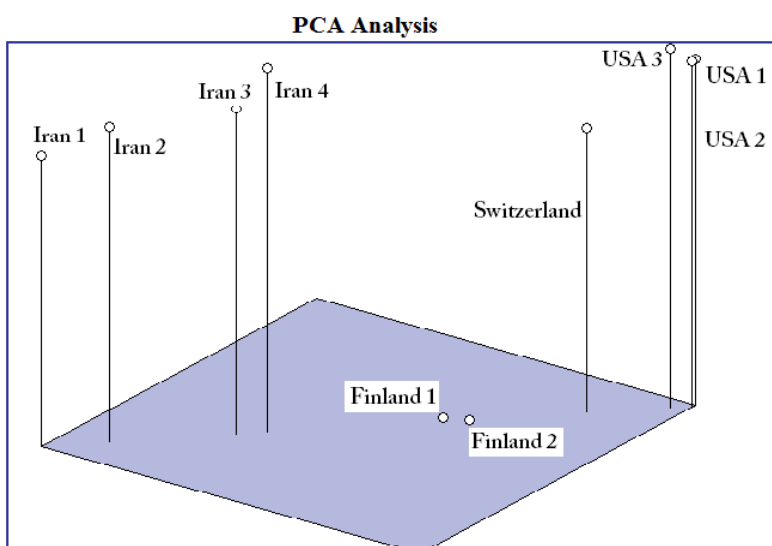
Figure 4. PCA analysis for 10 strains of H. pluvialis.